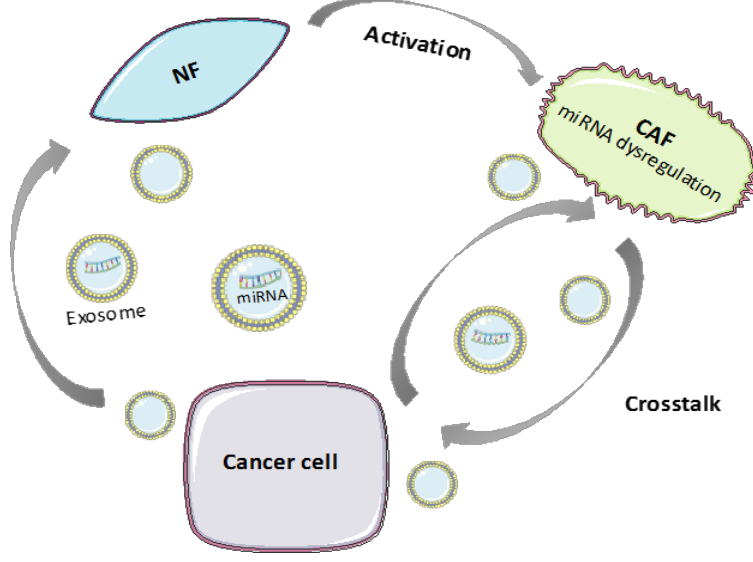
Figure 2. miRNAs play key role in the communication among normal fibroblasts (NFs), cancer associated fibroblast (CAFs), and cancer cells.